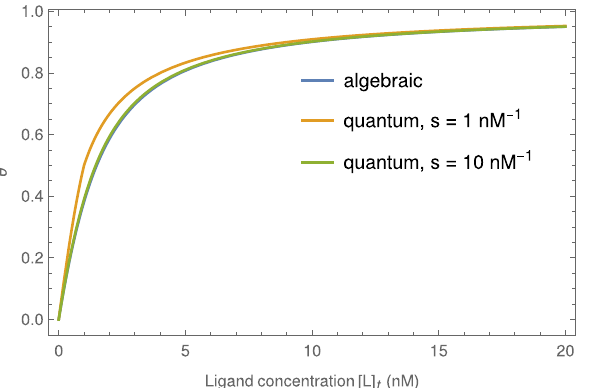
Figure 4. Comparison of θ , the concentration ratio of protein–ligand complexes to total protein, computed by 2 and 10 for the case of K d = [ P ] t = 1 nM .